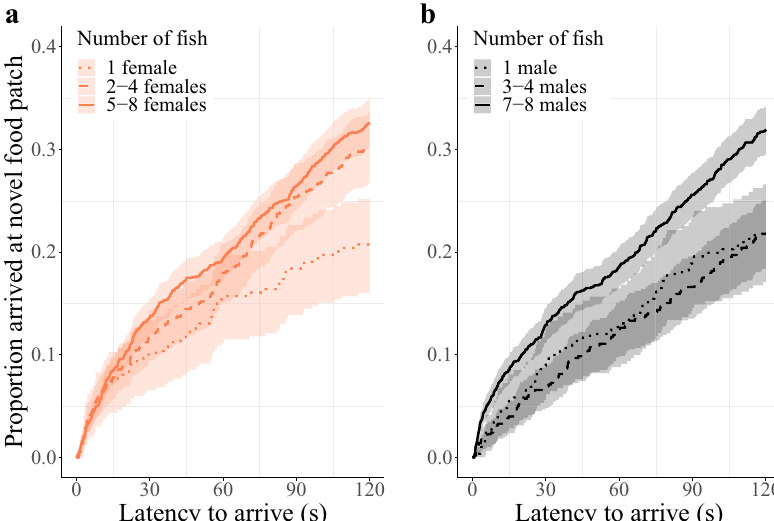
Fig. 2 Proportion of observations in which individuals arrived at the novel food patch as a function of time. Higher values on the y -axis re fl ect an increasing number of individuals arriving at a food patch by that time. Grouping of the number of fi sh in the pool for a females (orange) and b males (black) was conducted for graphical purposes only (solitary = dotted line, 2 – 4 fi sh = dashed line, 5 – 8 fi sh = solid line); analyses were conducted on an individual- by-trial level ( n uncensored / n total = 1423/4841) with fi sh number as a continuous covariate (Table 2). Note that there were no batches with two, fi ve or six males (Supplementary Table 2). Regression lines show the predicted values of a simpli fi ed model (excluding additional co-variates and random effects). Shaded areas around the lines re fl ect 95% con fi dence intervals.